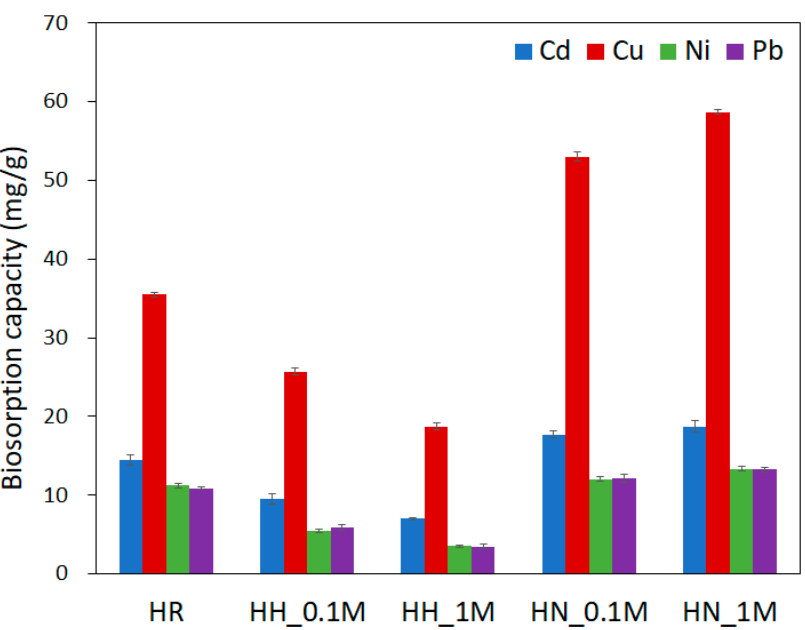
Figure 2. Effect of HCl and NaOH treatment on the pretreatment on H. fusiformis (HR: raw H. fusiformis without treatment; HH_0.1M and HH_1M: 0.1 M and 1 M HCl-treated H. fusiformis ; HN_0.1M and HN_1M: 0.1 M and 1 M NaOH-treated H. fusiformis ).